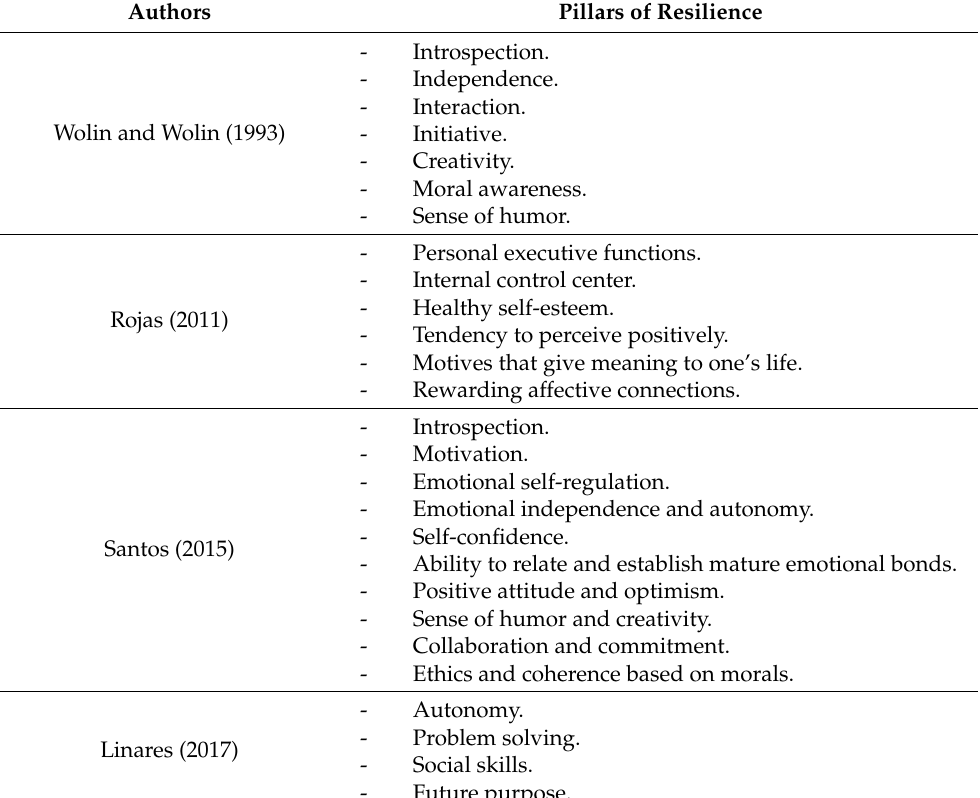
Table 5. Pillars of